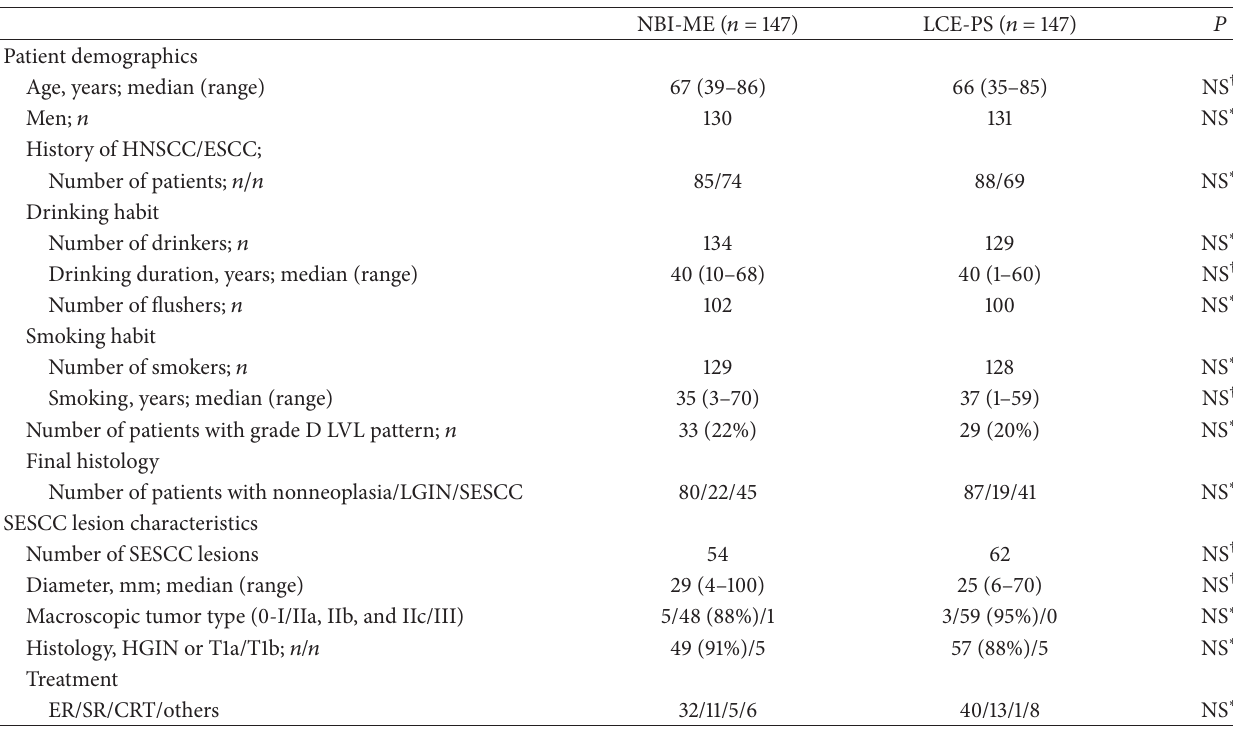
Table 2: Patient demographics and SESCC lesion characteristics.